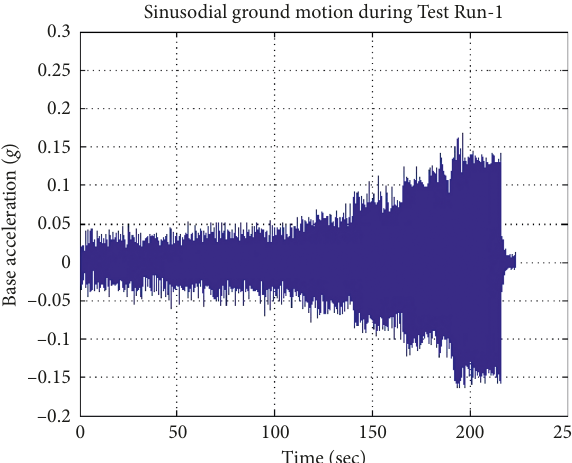
Figure 8: Acceleration recorded at the base during Test Run-1.